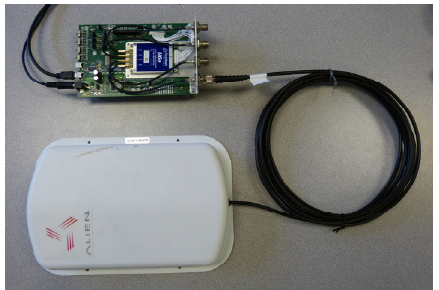
Figure 2. Initial prototype hardware.